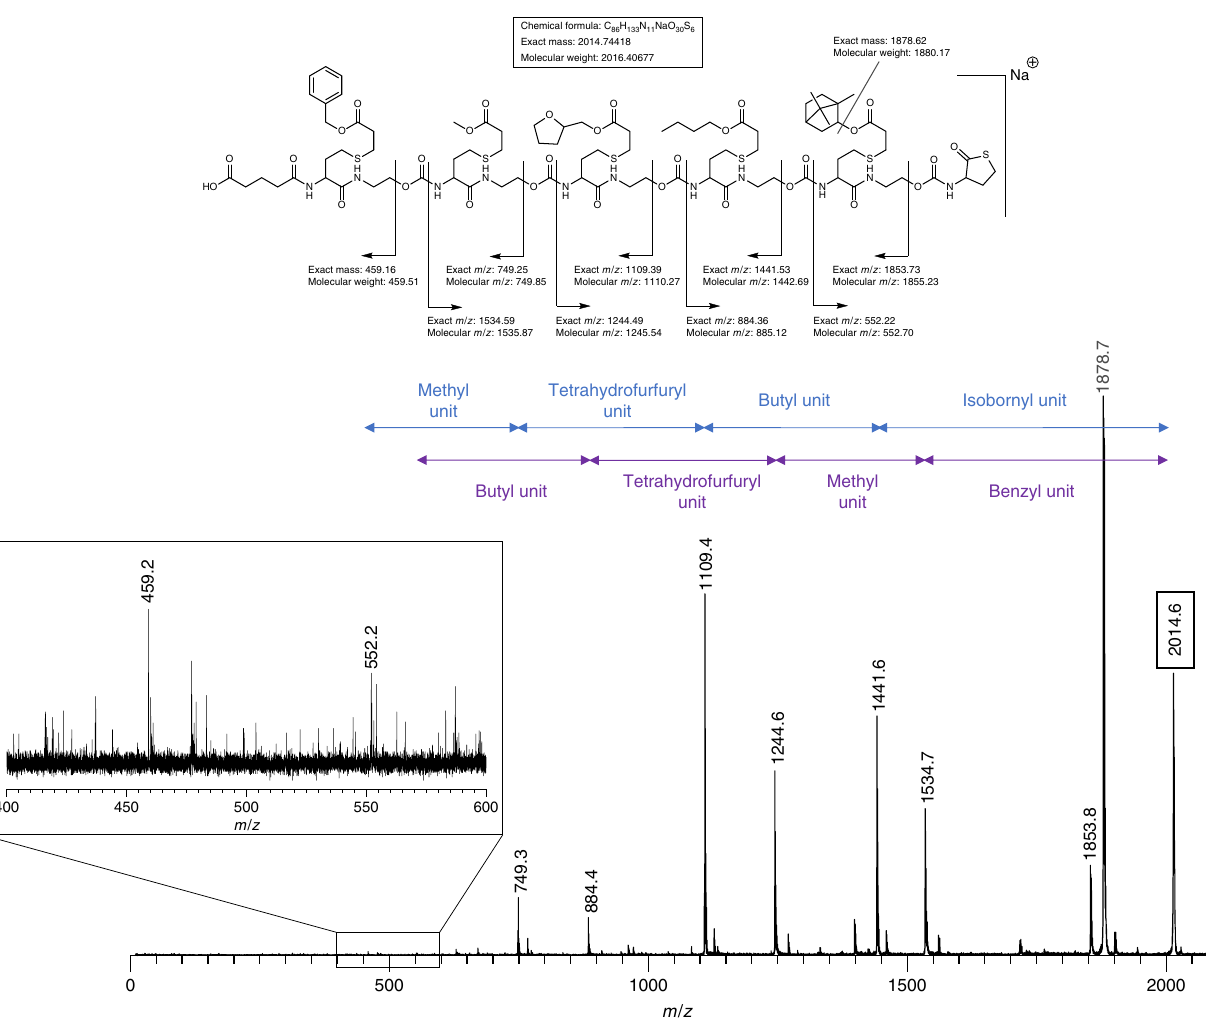
Fig. 2 Determining the sequence order. Tandem mass analysis (MALDI-MS/MS) of a pentamer Z5 with fi ve different functionalities. In blue the read-out is highlighted from right to left, in purple from left to right. The coloured arrows indicate the mass difference between two mass fragments and the functionality that is responsible for this difference.